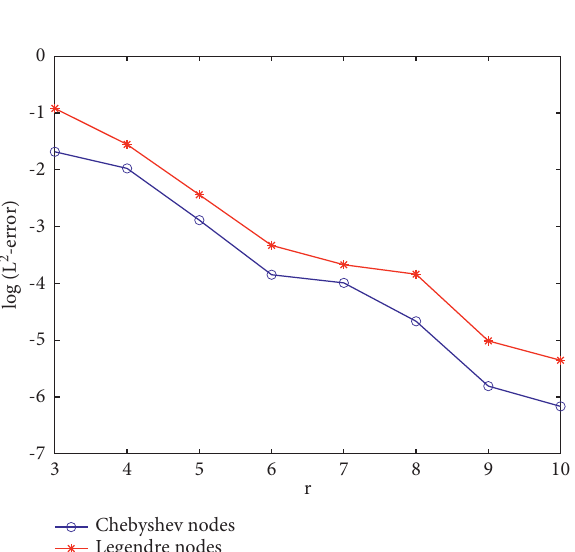
Figure 4: Plot of the L 2 -errors taking μ � ( 1/2 ) at the Legendre and Chebyshev nodes for Example